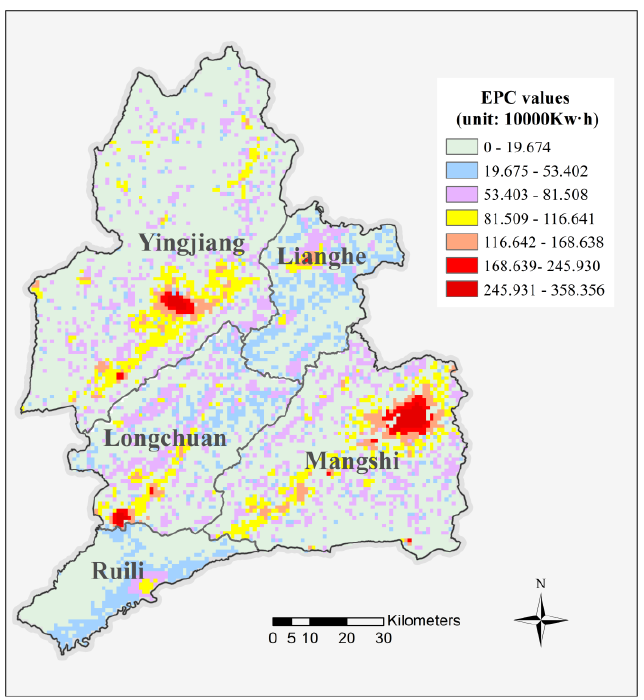
Figure 7. Spatialization results of electric power consumption (EPC) in the DH Prefecture in 2017.